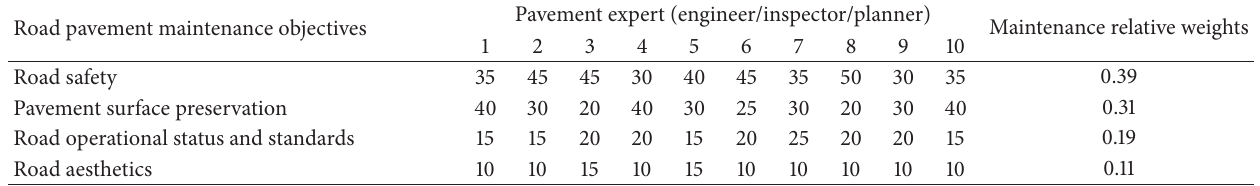
Table 6: Round 2 of judgment based on incremental linear ranking with 1.0 as the lowest importance. Road pavement maintenance objectives